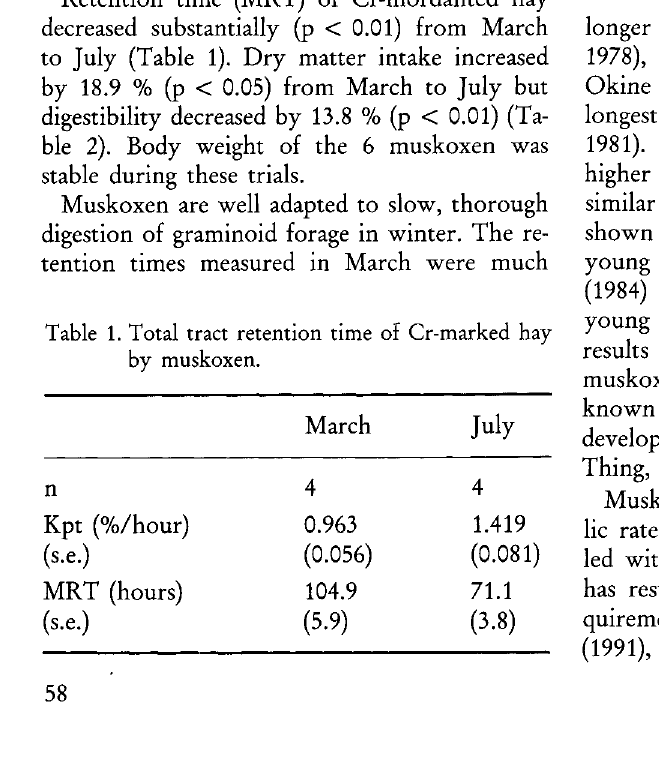
Table 1. Total tract retention time of Cr-marked hay by muskoxen.